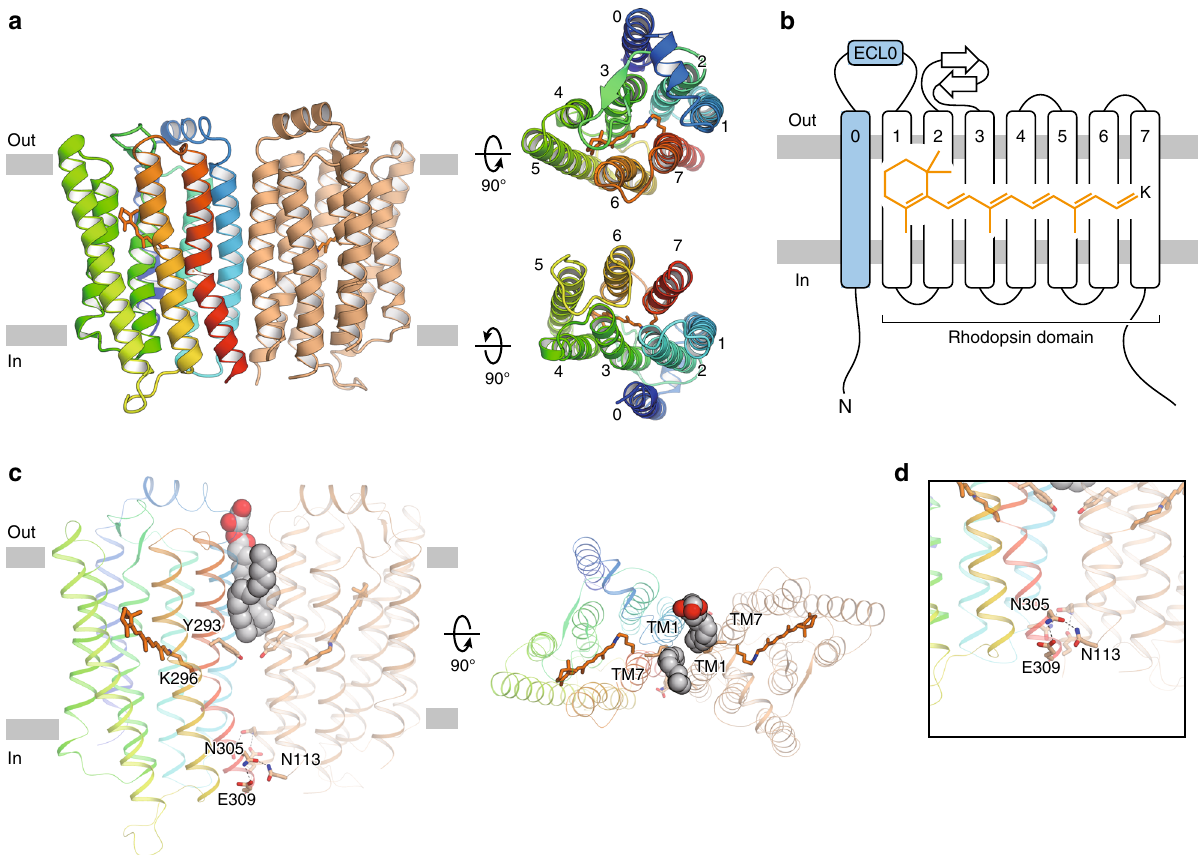
Fig. 1 Overall structure. a Ribbon diagrams viewed from the membrane plane (left), the extracellular side (upper right) and the intracellular side (lower right). One protomer is colored rainbow and the other is colored orange. The retinal chromophores are shown as orange stick models. b Schematic representation of the ribbon diagram. c Monoolein molecules and residues at the dimer interface, viewed from the membrane plane (left) and the extracellular side (right). Monoolein molecules are shown as spheres with gray carbon atoms and red oxygen atoms. d Close-up view of the residues on the intracellular